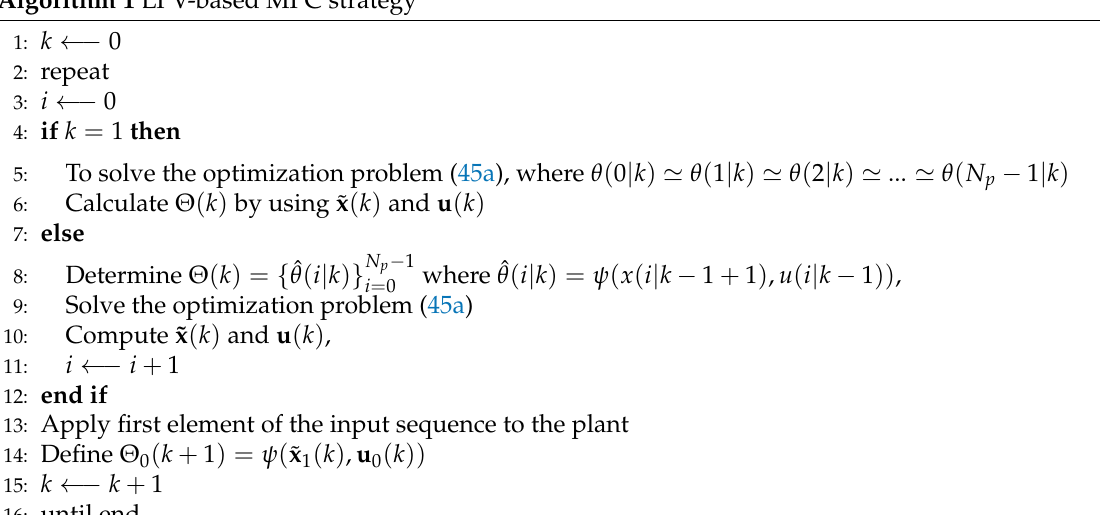
Algorithm 1 LPV-based MPC